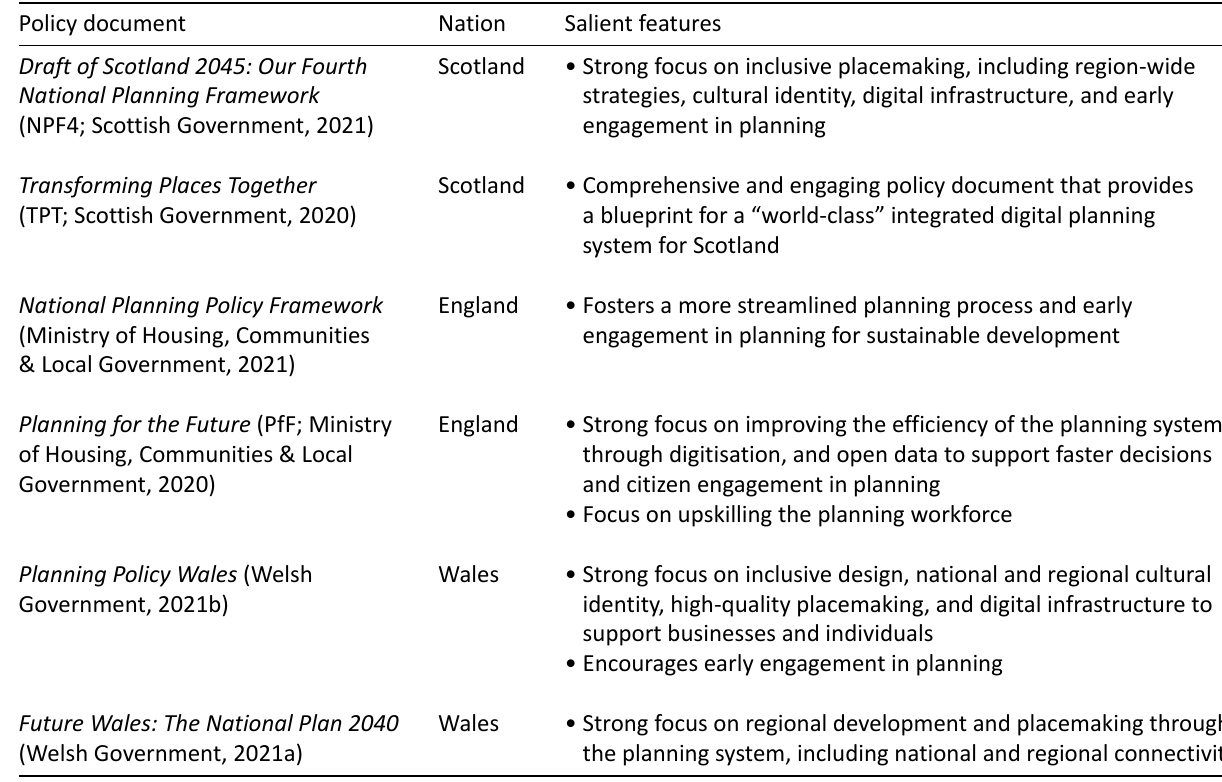
Table 1. High‐level national planning policy guidance documents that identify opportunities for public